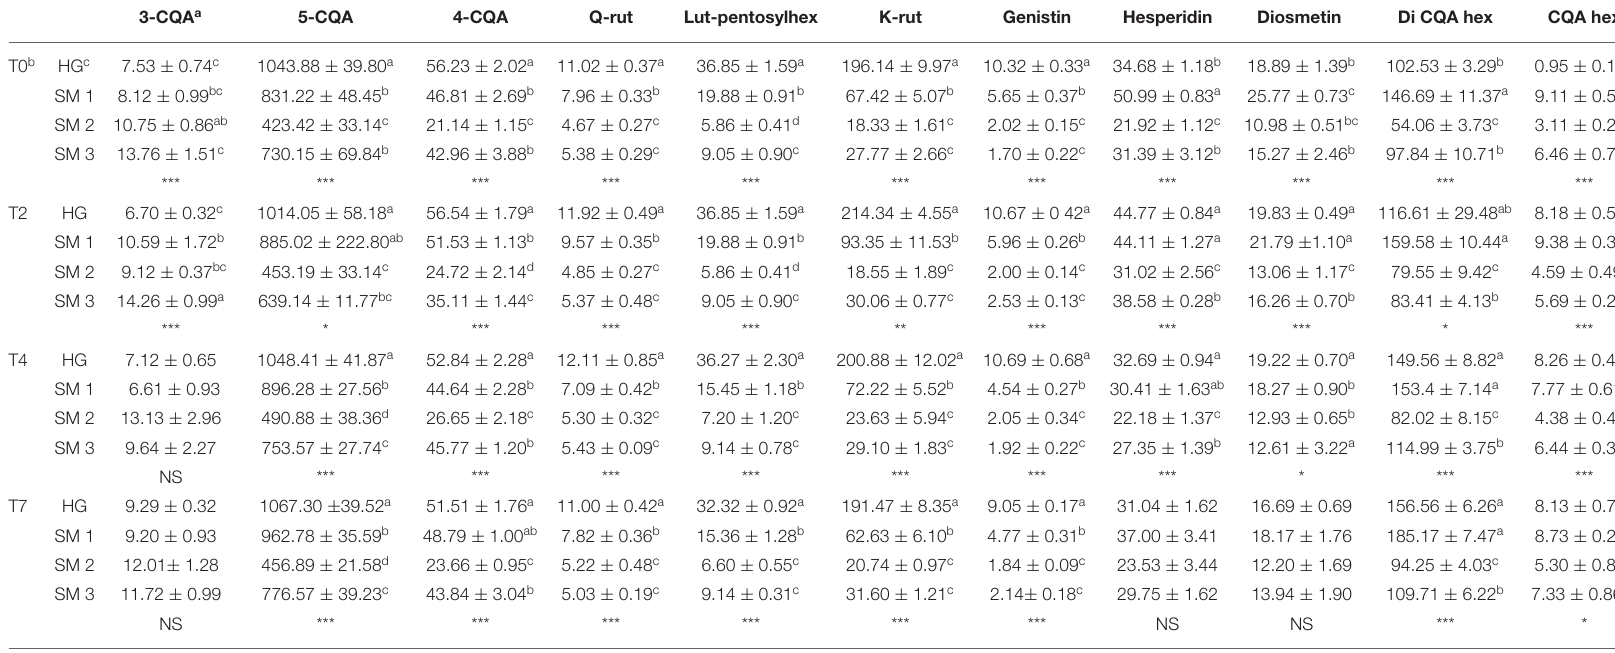
TABLE 2 | Individual phenolic compounds (mg kg − 1 FW ± SE) in different V. locusta “Vit” samples during refrigerated